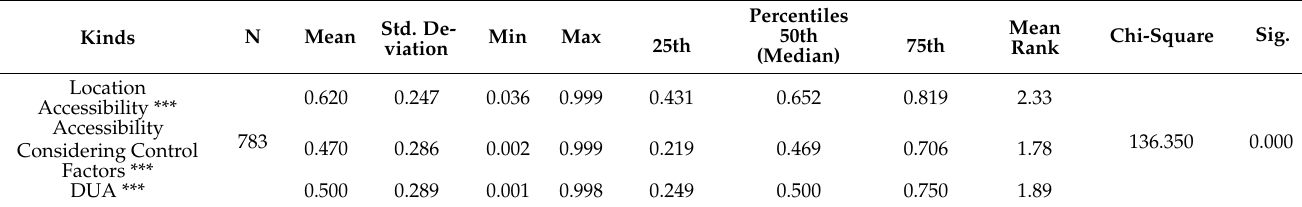
Figure 8. A 3D scatter plot created by the location integration of public libraries, integration accord- ing to control factors, and